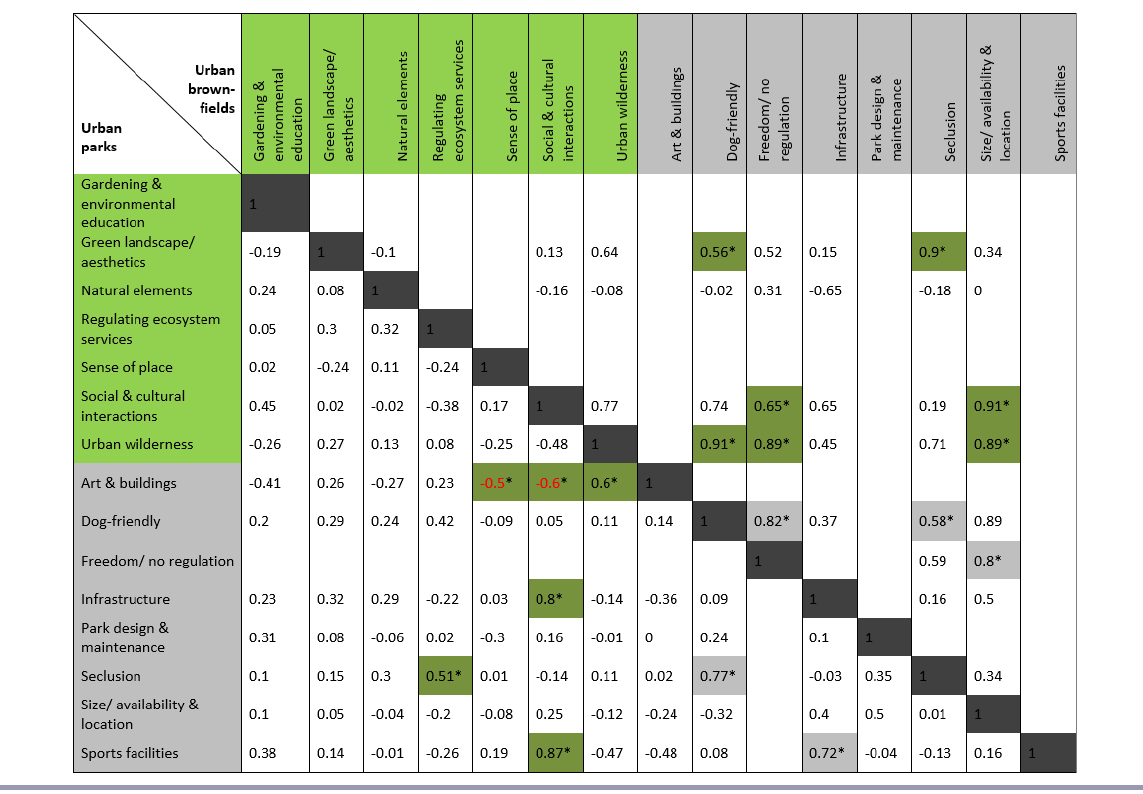
Fig. 5 . Correlation matrix (weighted Spearman’s correlation) for pairs of perceived benefits in 18 urban parks and 13 urban green brownfields. Numbers below the black diagonal line show correlation coefficients for aspects of urban parks, above the line correlations for urban brownfields. Respondents could name multiple categories. Categories representing nature benefits are in light green; gray benefits are gray. Significant (*on 95% confidence interval for 1000 bootstrapped resamples, see Appendix 1, Tables A1.4, A1.5) positive or negative correlations ≥ 0.5 between two nature benefits are marked in light green, correlations between nature benefits and gray benefits are in dark green; correlations between two gray benefits are marked in